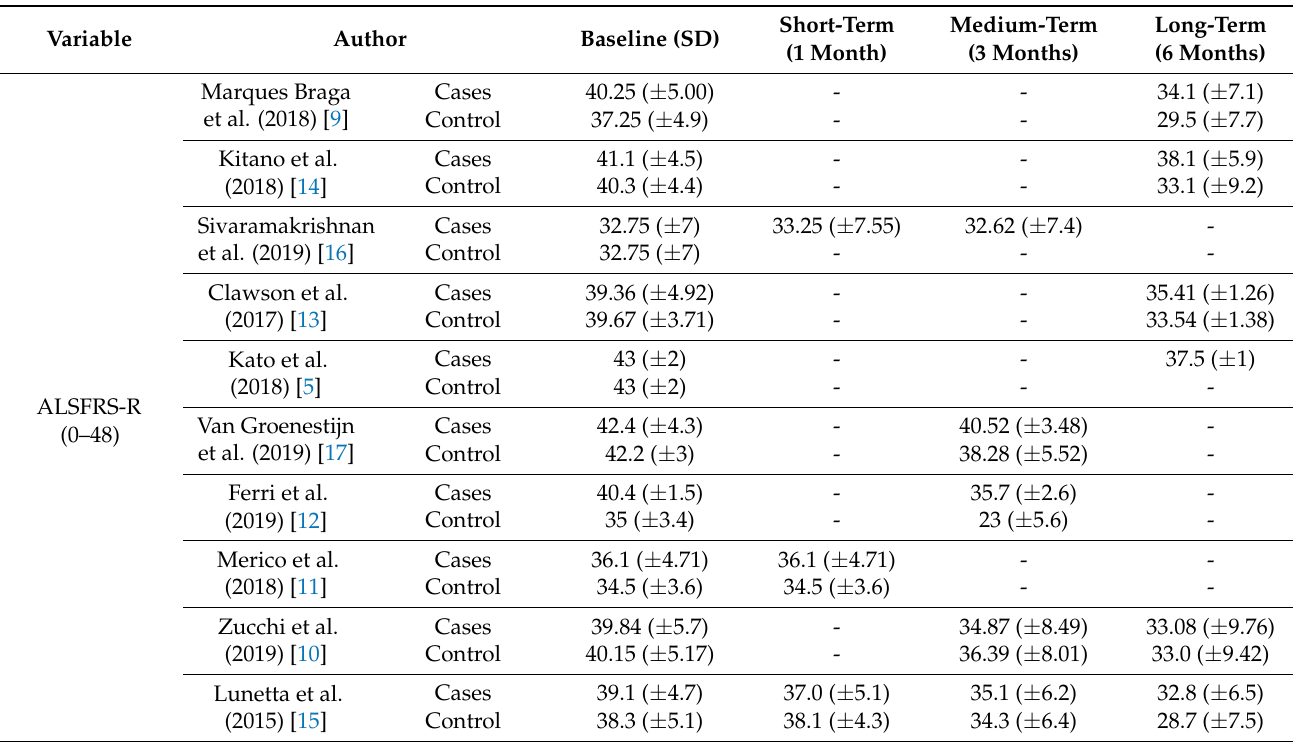
Table 3. Summary of the ALSFRS-R outcome variable.